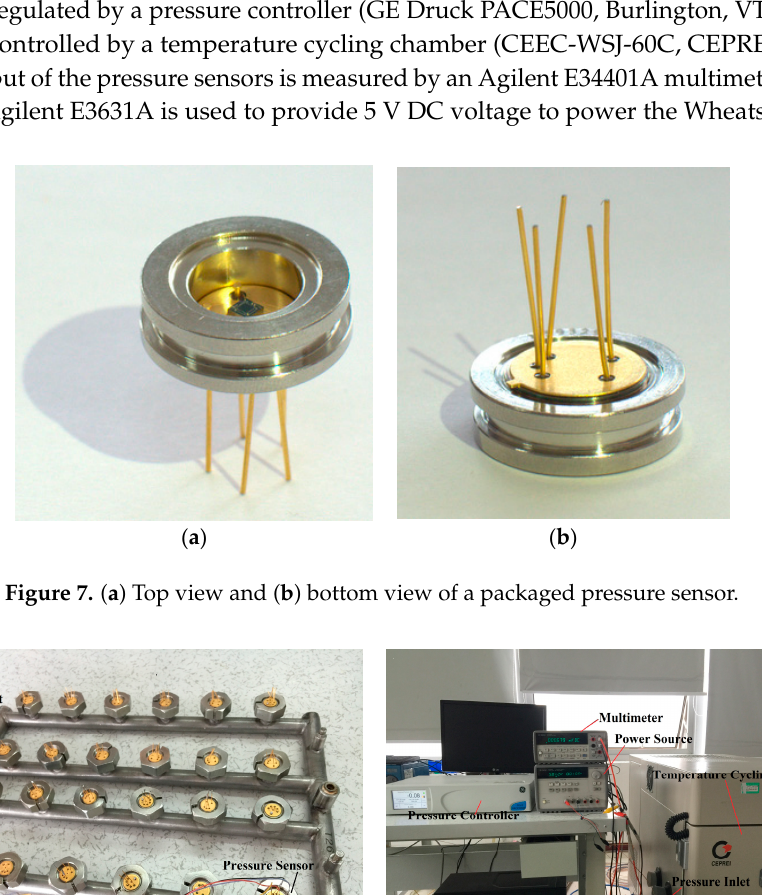
Figure 8. ( a ) A custom-made fixture and ( b ) testing apparatus for pressure sensor characterization.